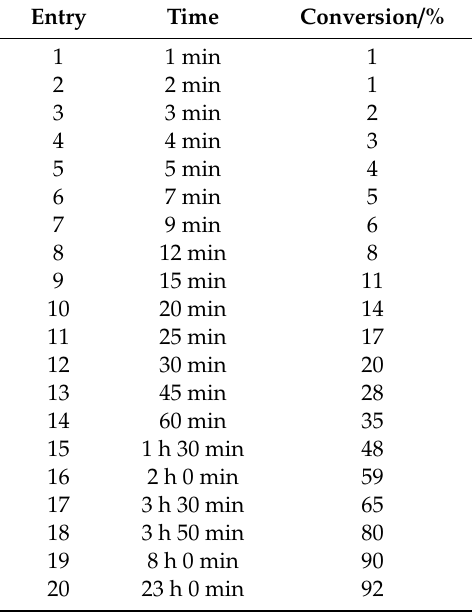
Table A9. Reduction of acetophenone ( 1 ) to 1-phenylethanol ( R )- 2 . Change from standard procedure: doubled enzyme and cofactor loadings.